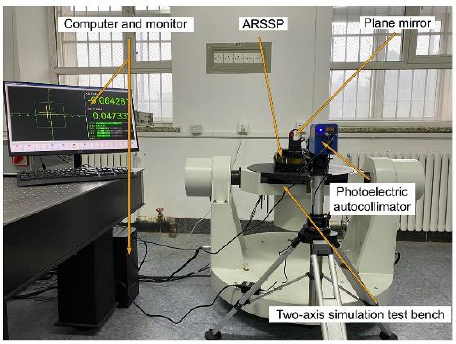
Figure 10. Indoor test site.